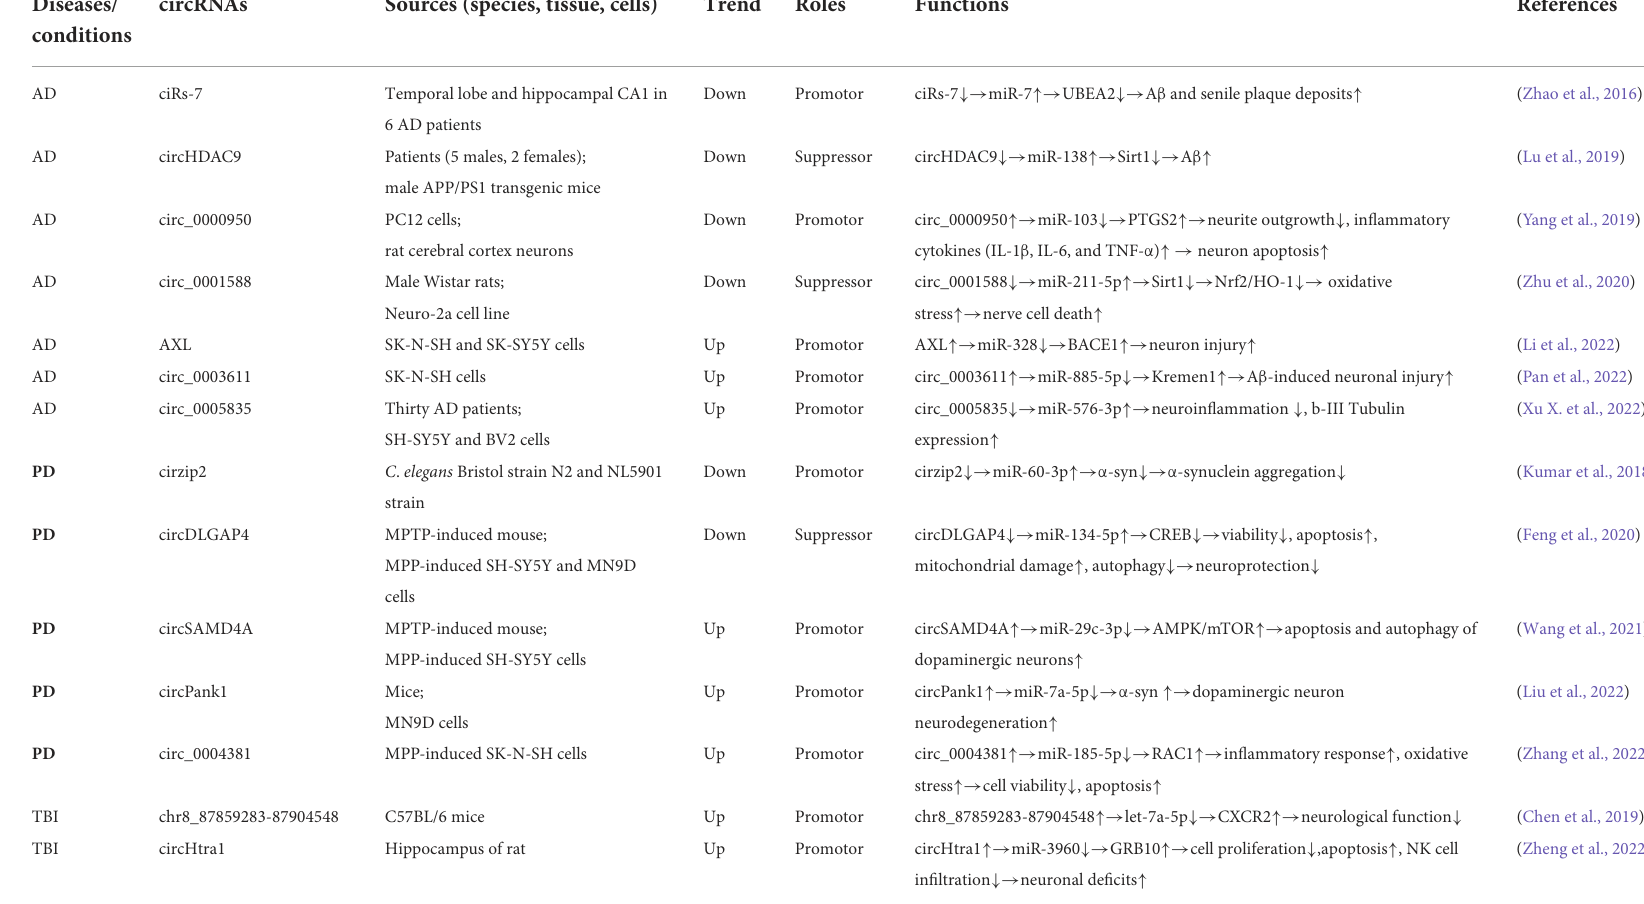
TABLE 1 Circular RNAs (CircRNAs) in various brain cognitive